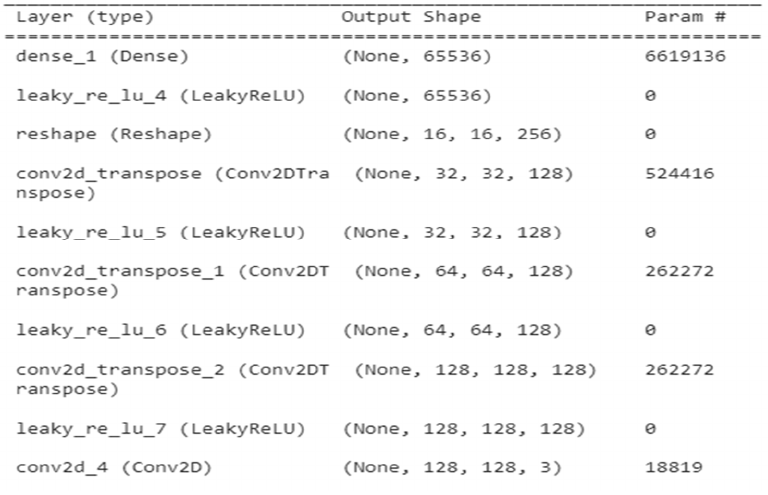
Figure 4. Generator GAN for several layers .